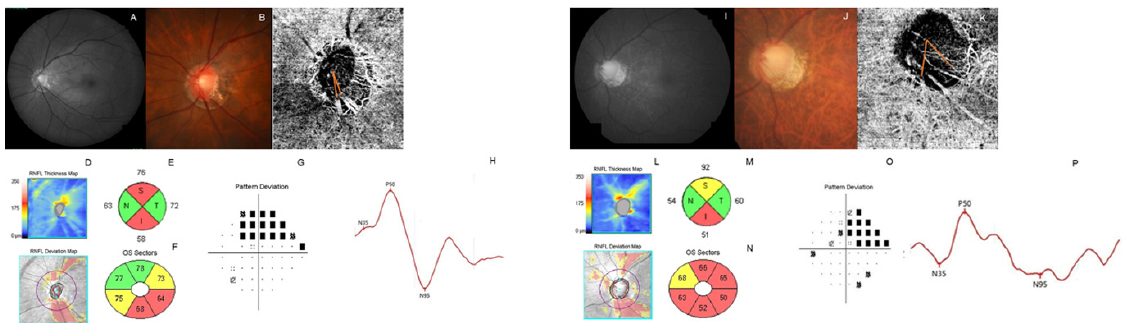
Figure 3. A representative case of comparing patients in terms of angular width of MvD. A 53-year- old male with multiple RNFL defects ( A , B ) had the MvD with an estimated angular width of 9.9° ( C ). Another patient (63 years old) ( I , J ) presented with larger MvD (angular width 54.9°; ( K )). Regarding the level of disease severity, the patient with smaller MvD had average 67 μ m RNFL and 72 μ m GCIPL thicknesses ( D – F ), and VF MD was − 8.43 dB ( G ). Similarly, the patient with larger MvD had average 64 μ m RNFL and 65 μ m GCIPL thicknesses and MD − 8.92 dB ( L – O ). Despite the equivalent glaucoma stage, the patient with lager MvD saw significantly reduced P50 and N95 amplitudes than the patient with smaller MvD (2.46 mV and 2.96 mV, respectively, ( P ) vs. 2.58 mV and 6.58 mV, respectively, ( H )).